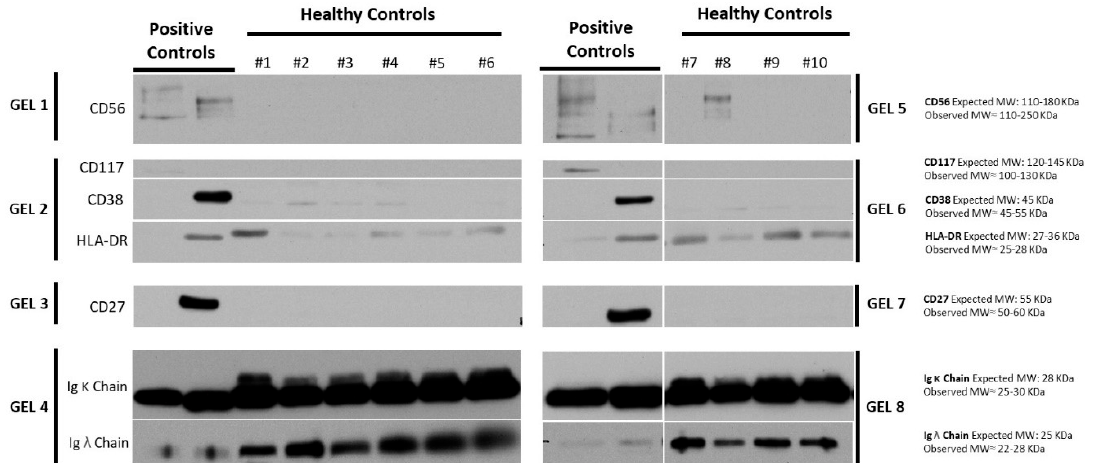
Figure 4. Comparison of the size and concentration of the EVs isolated by Size Exclusion Chromatography (SEC) and concentrated by ultrafiltration (UF) from Multiple Myeloma (MM) patients and healthy controls. ( A ) Average size of the isolated EVs from PB and BM samples of both diagnosis and remission MM patients and from healthy controls. Results are the mean ± standard error (SE) of the particle size obtained by NTA from at least six samples. ( B ) Particle concentration of the isolated EVs from PB and BM samples from both diagnosis and remission MM patients and from healthy controls. Results are the mean ± standard error (SE) of particle concentration obtained by NTA from at least six samples. * p < 0.05. PB: peripheral blood; BM: bone marrow; SEC: Size Exclusion Chromatography; UF: ultrafiltrated pool of SEC fractions 3 to 6; NTA: Nanoparticle Tracking Analysis; MM: Multiple Myeloma.